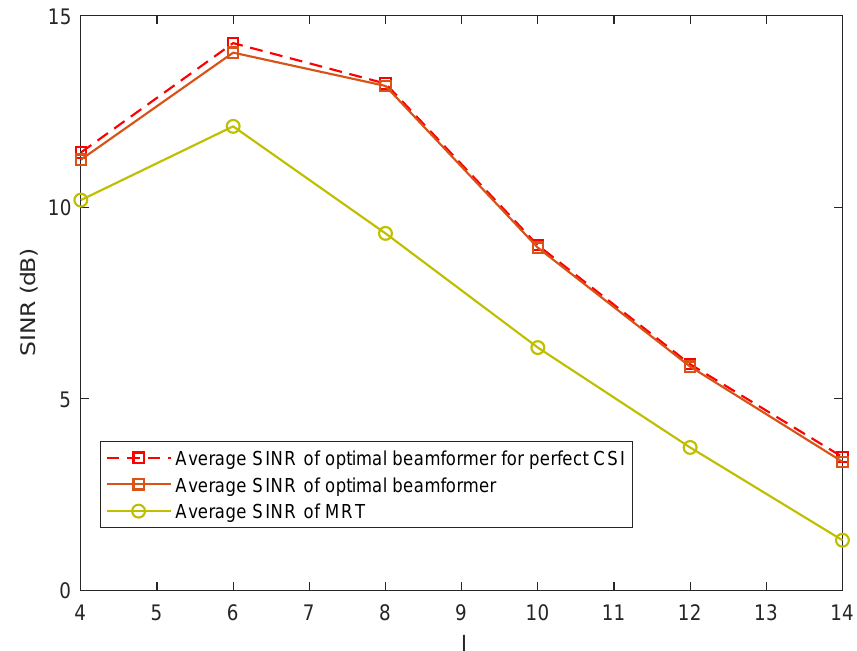
Figure 6. The achieved SINR among several algorithms with regard to I ( M = 64, P = 30, K = 3, r = 0.7, τ =